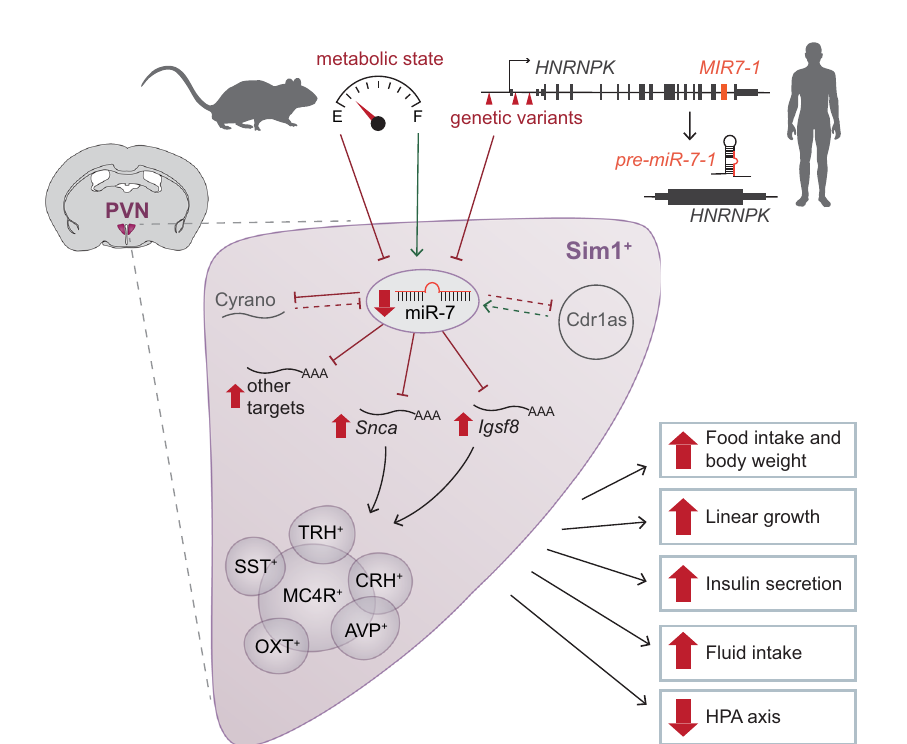
Fig. 7 | The role of miR-7 in Sim1 neurons to regulate mammalian energy homeostasis and neuroendocrinefunction. In mice,hypothalamic expressionof miR-7 is regulated by metabolic state. In humans, variants in the locus encom- passing miR-7 are associated with reduced expression of HNRNPK/MIR-7-1 . miR-7 regulates the expression of the noncoding RNAs Cyrano and Cdr1as (dashed lines indicate previously published data 35 ). Loss of miR-7 expression in Sim1 neurons